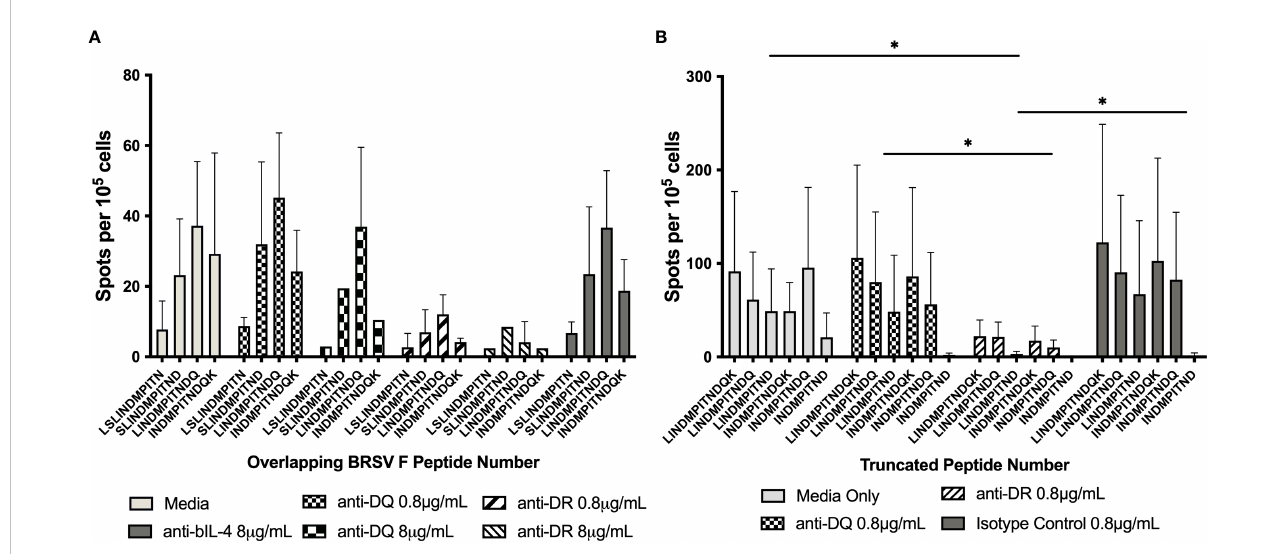
FIGURE 3 Inhibition of BoLA DR, but not BoLA DQ, signi fi cantly reduces CD4 + T cell activation. Antigen presenting cells were incubated with antibodies against BoLA-DR or BoLA-DQ molecules prior to stimulation with synthetic overlapping peptides (A) or C-terminal truncated peptides (B) . Antibodies raised against MHC class II molecules were provided as mouse ascites fl uid. A reduction of in T cell stimulation was observed only with following pre-treatment with anti-BoLA DR antibodies (A) . Antibodies were puri fi ed to ensure the reduction in T cell stimulation was due to antibody binding and not background from ascites fl uid (B) . Anti-bovine IL-4 antibody was used as an isotype control. Cells were cultured in cRPMI as a media only control. Data is presented as mean ± SEM, p < 0.05 was considered signi fi cant and indicated by asterisk.